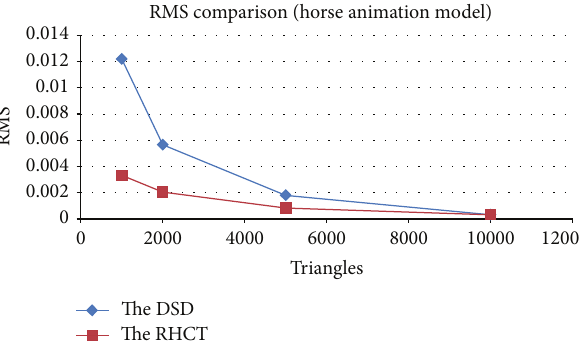
Figure 7: RMS error comparison for simplifying horse animation